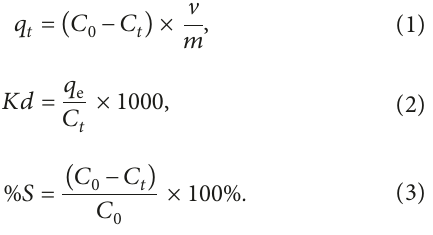
Figure 1: Pourbaix’s diagram of Fe-S-H Hydra-Medusa software at 25 °